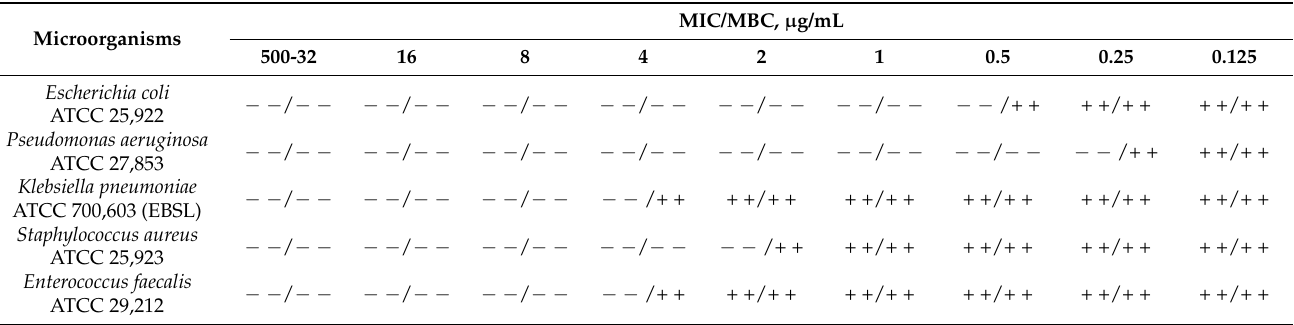
Table 1. Antimicrobial activity of AgNP nanocomposite.